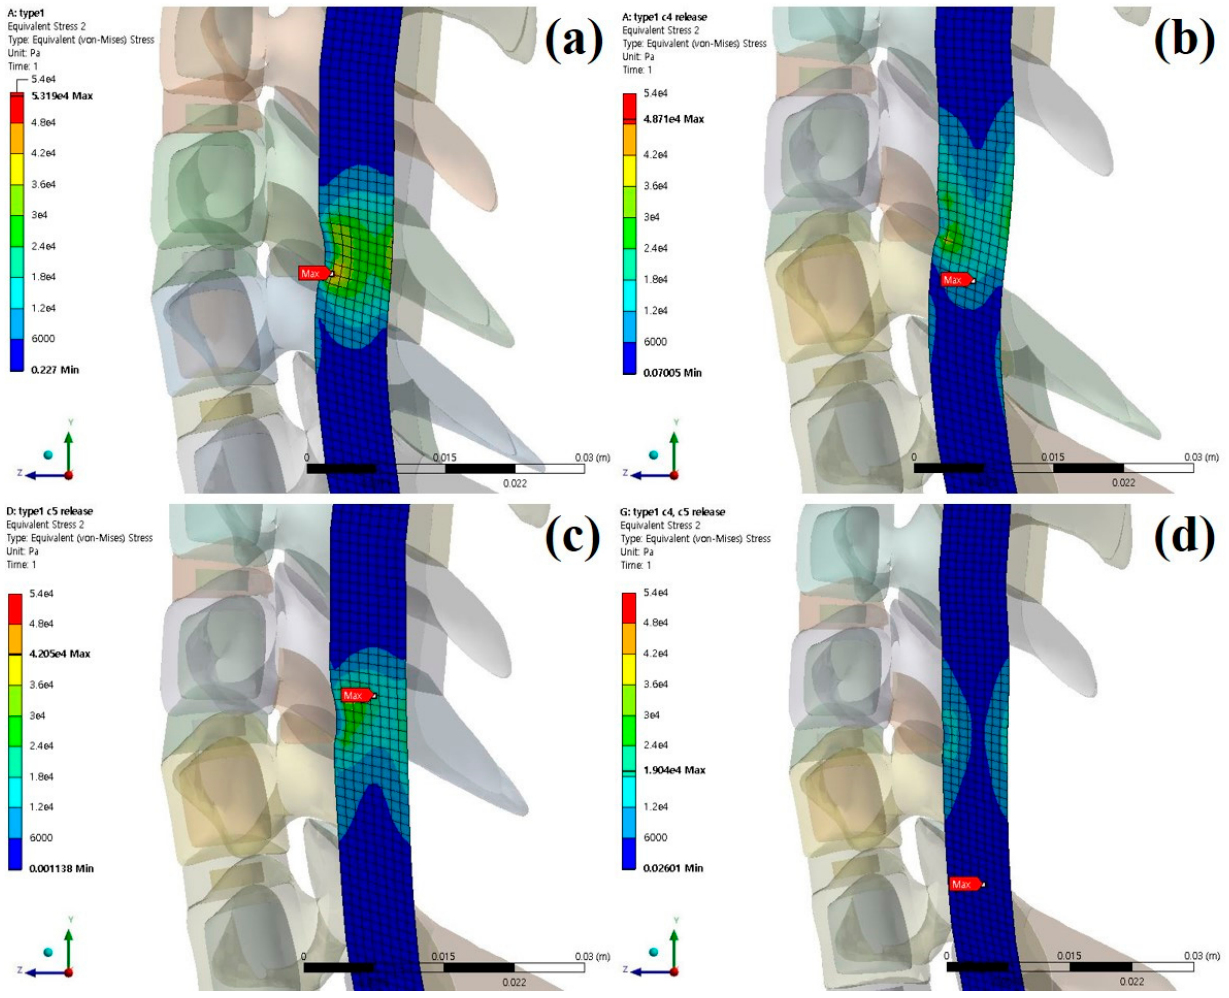
Figure 6. Neutral laminectomy simulation type 1 OPLL: ( a ) non-surgery model equivalent stresses (Pa); ( b ) C4 laminectomy model equivalent stresses (Pa); ( c ) C5 laminectomy model equivalent stresses (Pa); and ( d ) C4-C5 laminectomy model equivalent stresses (Pa).